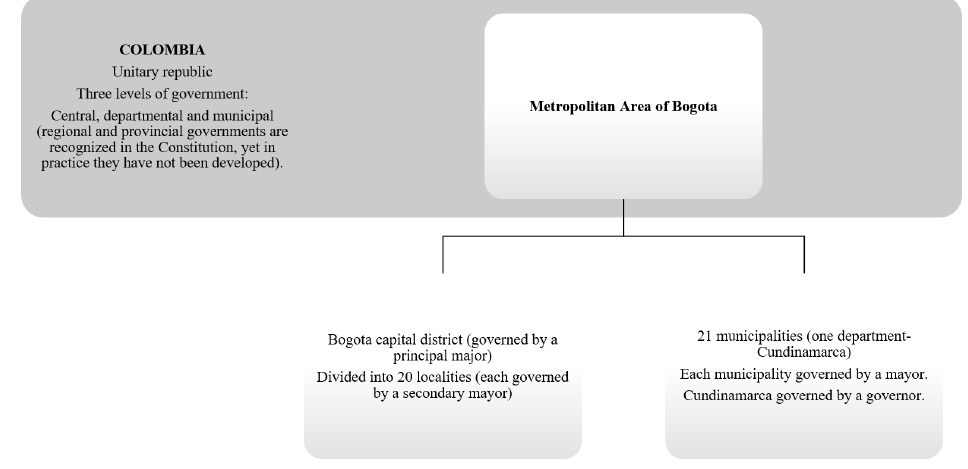
Figure 8: Government structure, Metropolitan Area of